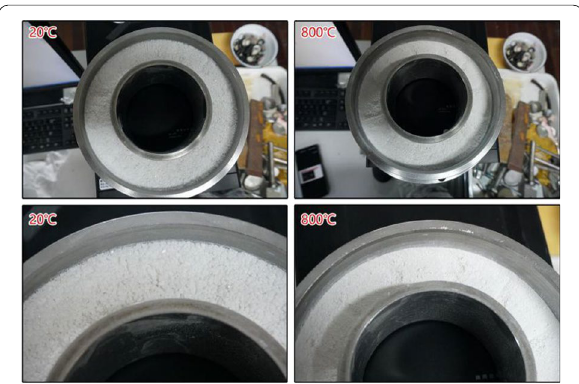
Fig. 10 Calcareous sand samples after being subjected to different temperatures